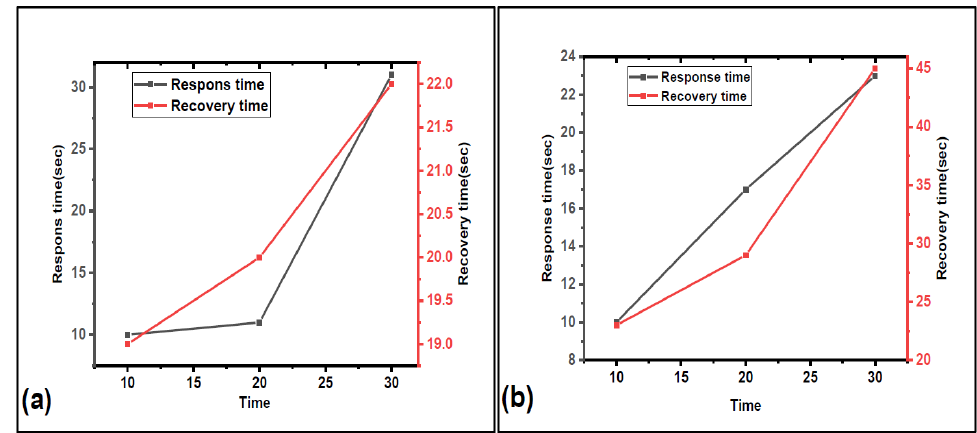
Figure 8: Response and recovery time versus start time for a PS with different current densities for (a) acetone and (b) ethanol at 500